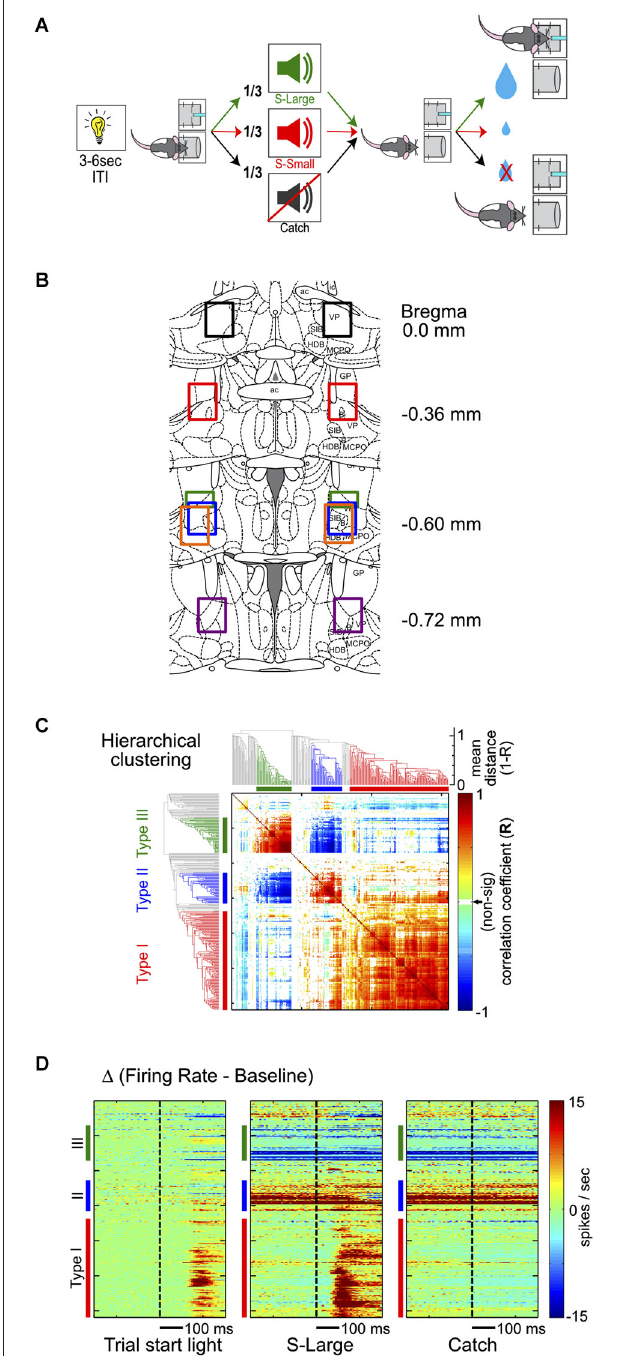
FIGURE 1 | Hierarchical clustering analysis of BF neuronal response types. (A) Schematic of the reward-biased simple RT task. Each trial is initiated by a house light signal, prompting rats to enter a nosepoke fixation port. Rats encounter three possibilities while maintaining fixation: (1) S-Large sound predicting 4 drops of water in the adjacent reward port; (2) S-Small sound predicting 1 drop of water; or (3) Catch trials with no sound and no reward. (B) Histological reconstruction of electrode locations. Each color represents the reconstructed recording area from one